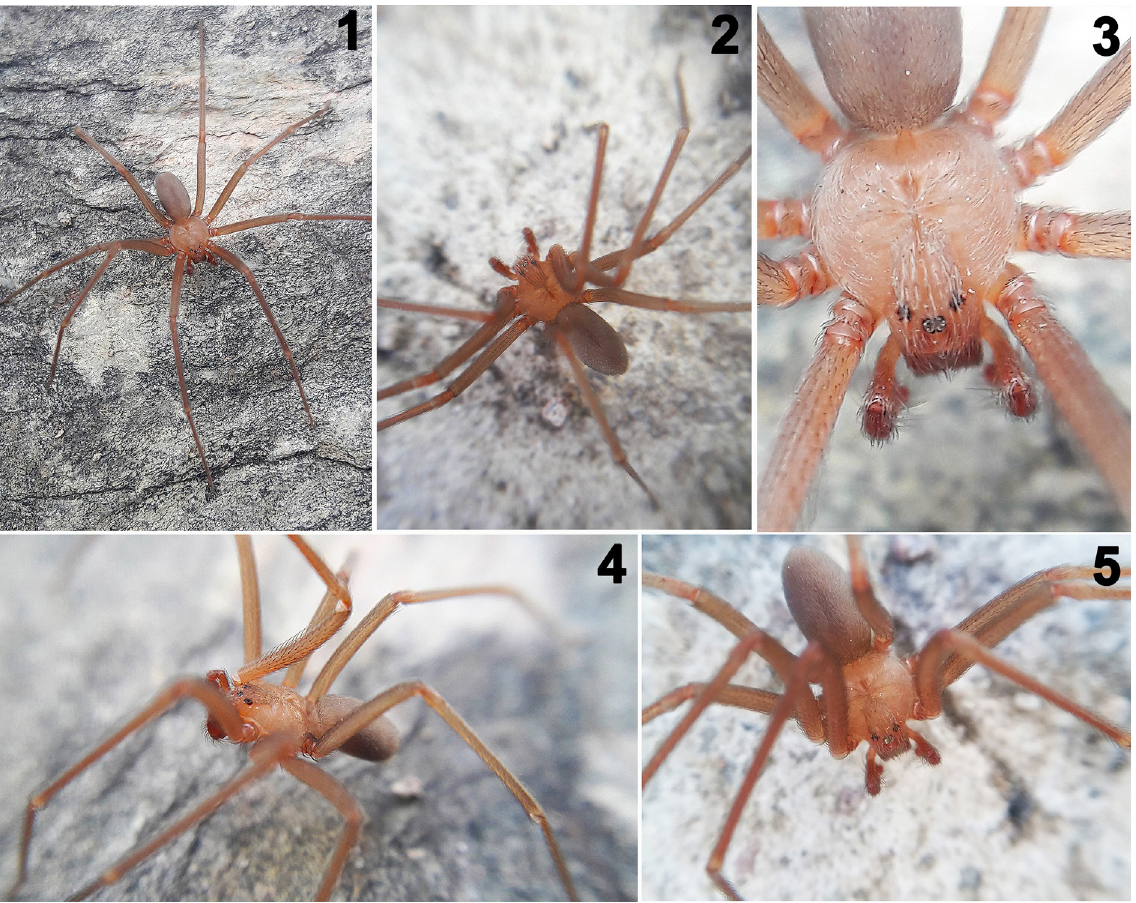
Figs 1–5. Live male holotype (CNAN-T01317) of Loxosceles tolantongo sp. nov. from the type locality: Tourist Center Grutas de Tolantongo, Municipality of Cardonal, Hidalgo, Mexico. Photos 1–4 by Alejandro Valdez-Mondragón (2019); photo 5 by Claudia Isabel Navarro-Rodríguez